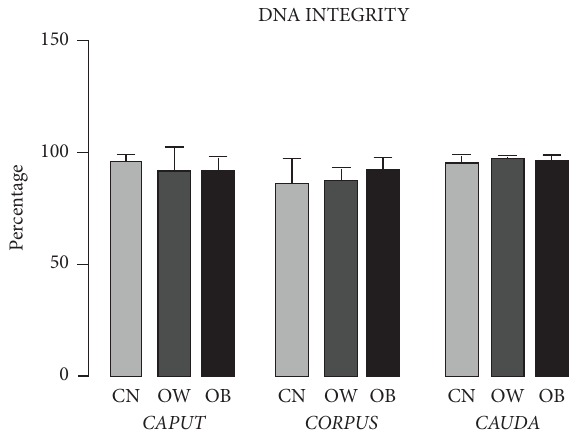
Figure 5: Sperm DNA integrity in the caput , corpus, and cauda regions of the epididymis of Wistar rats fed for four weeks with regular chow (control group (CN)) or hyperlipidemic diets (overweight (OW) and obese (OB) groups). Bars represent mean ±